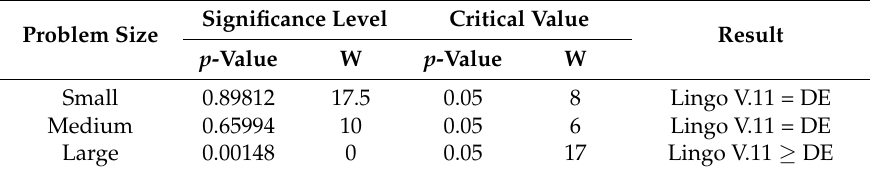
Table 20. Statistical test